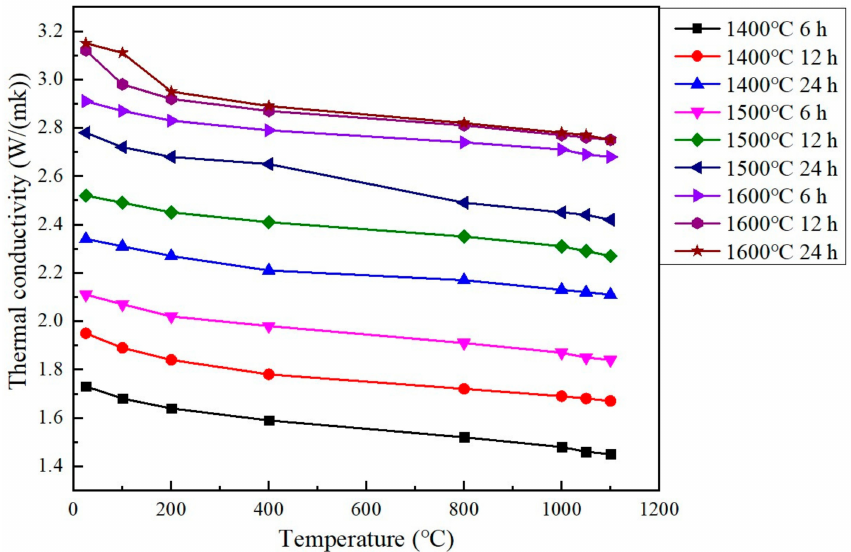
Figure 4. The sintered Gd 2 O 3 bulks’ thermal